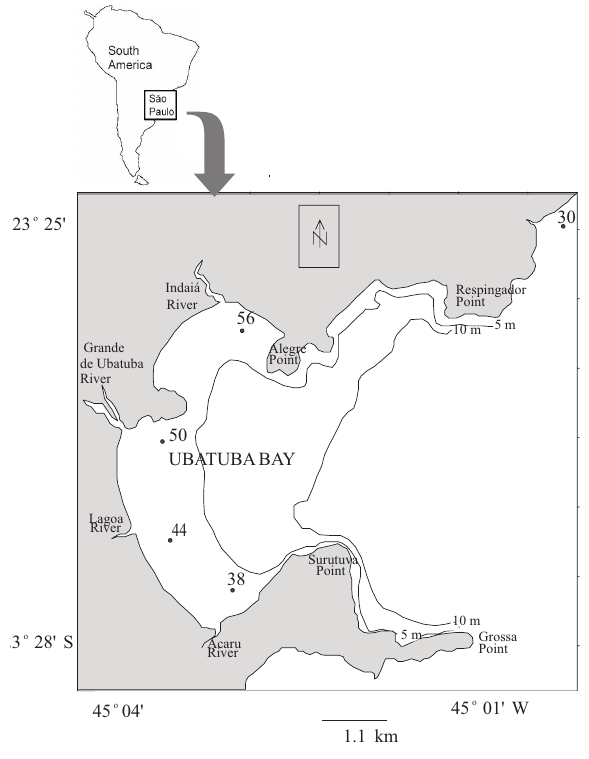
F IG . 1. – Study area map with the 4 sampling stations (black